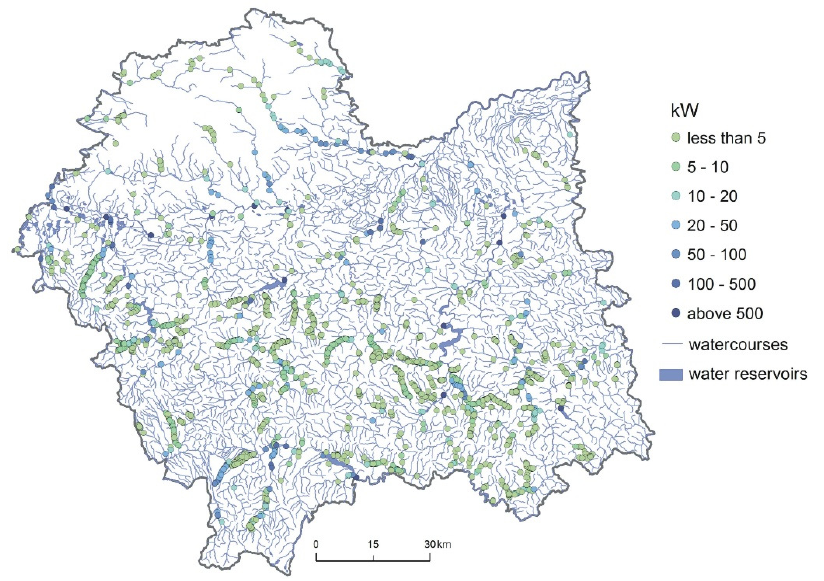
Figure 11. Localization of water dams and power of the potential hydropower plants in the Małopol- skie voivodeship (own elaboration). The power of all the potential hydropower plants in the Mazowieckie voivodeship on dams is 14.8 MW (Figure 12).